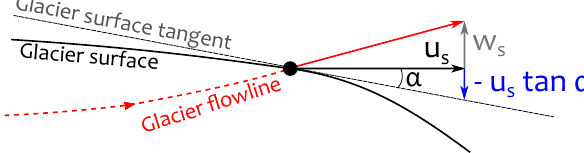
Figure 3. Definition of the different flow components, u s is the hori- zontal velocity, w s the vertical velocity and α the angle of the glacier surface tangent; adapted from Hooke